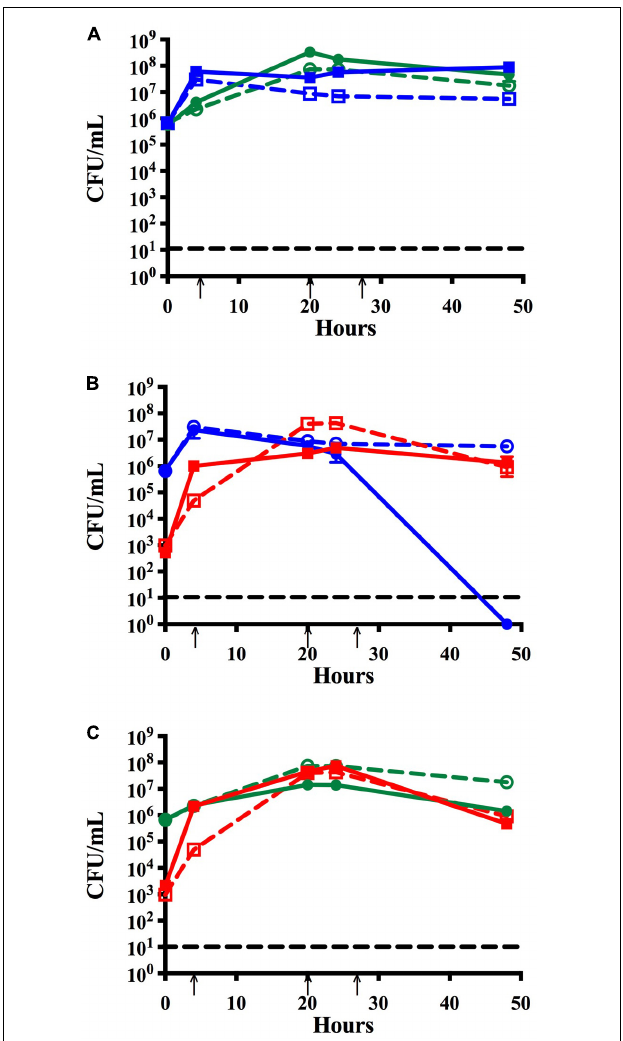
FIGURE 1 | Time course assay analyzing monomicrobial and dual species biofilms in vitro . Bacteria were grown in monomicrobial (dashed) or dual species (solid) biofilms and maintained with media changes (black arrows) for 48 h. (A) NTHi86-028 NP (blue) and M. catarrhalis 7169 (green) monomicrobial and dual species biofilms. (B) NTHi86-028 NP (blue) and S. pneumoniae EF3030 (red) monomicrobial and dual species biofilms. (C) M. catarrhalis 7169 (green) and S. pneumoniae EF3030 (red) monomicrobial and dual species biofilms. Black dashed line indicates the limit of CFU detection. Each symbol and error bar represent the mean CFU per mL and standard deviation (SD) of biofilms at the respective time point. Data presented are from three independent assays with a minimum of two biologic replicates per assay.